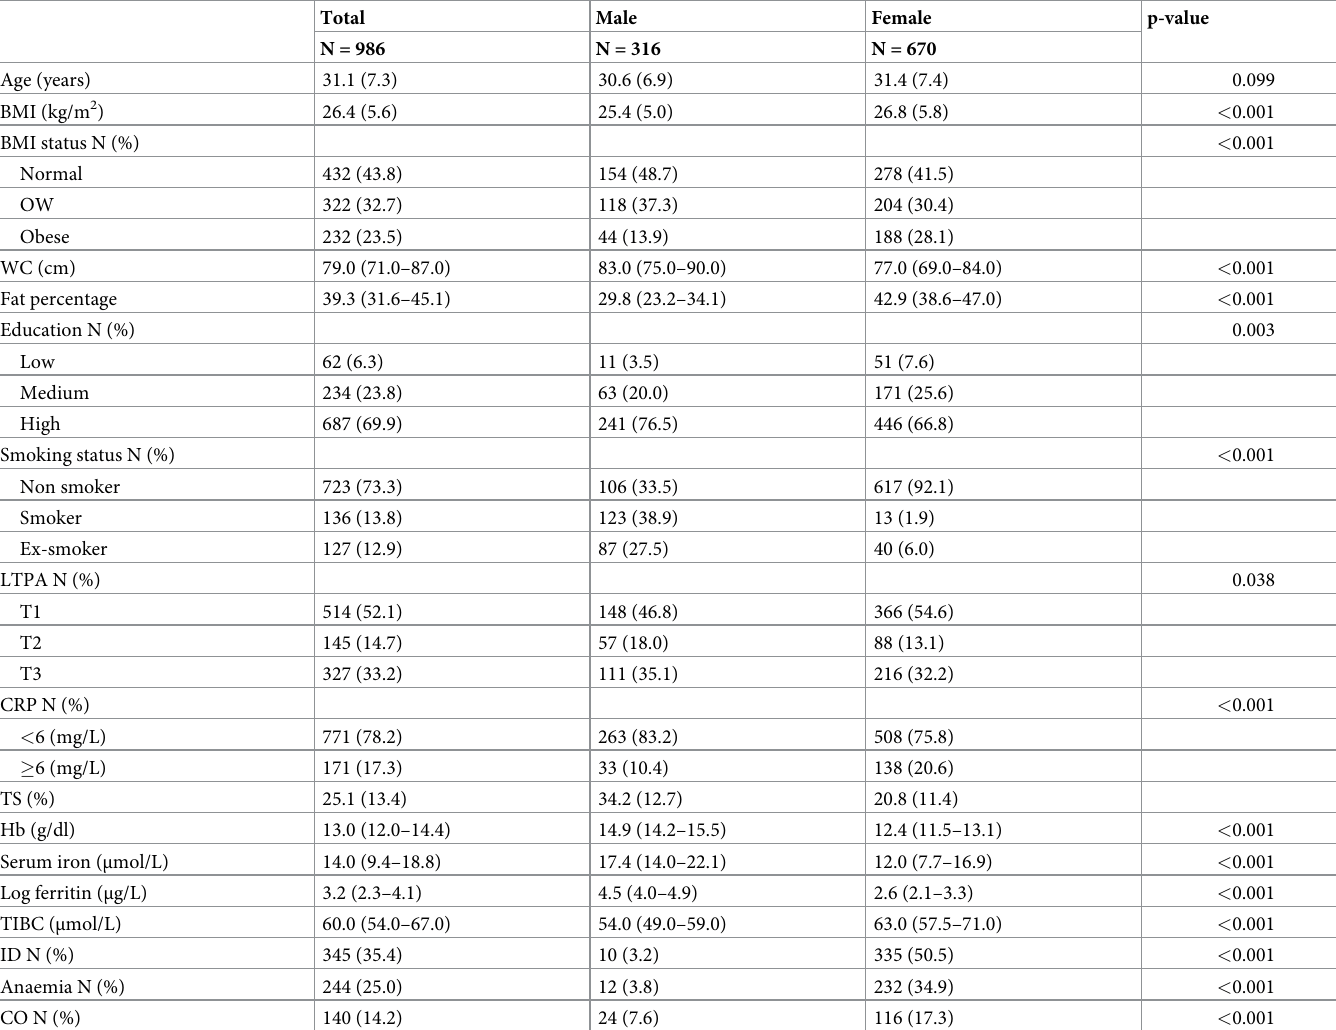
Table 1. Sample characteristics by